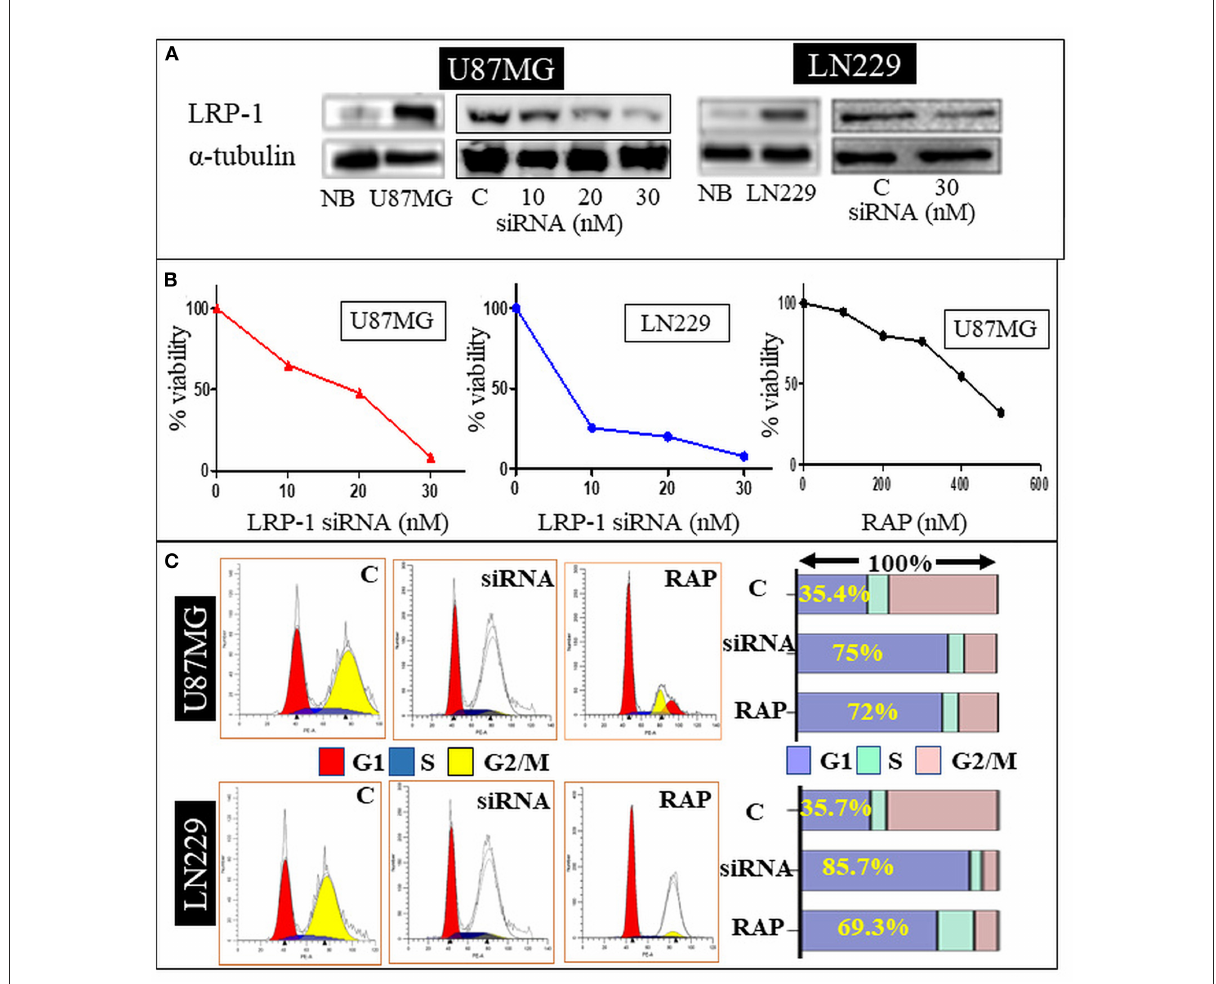
FIGURE3 In-vitro study. Western blot analysis of siRNA treated U87MG and LN229 cell line showing a dose dependent decrease in the LRP-1 expression (A) . MTT assay showing dose depended decrease in the cell variability and proliferation after LRP-1 knockdown and RAP treatment (B) . Cell cycle analysis -Gene knockdown and RAP treatment was associated with increase cell in G1 phase (C)